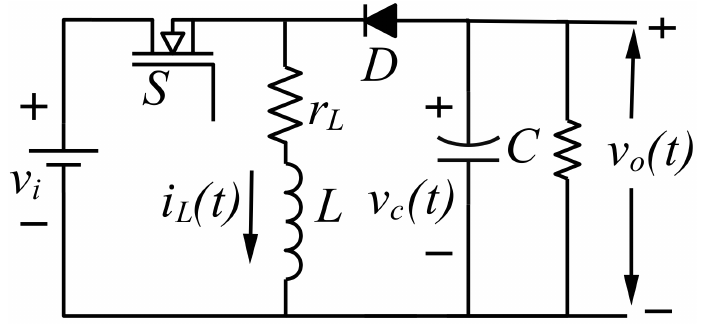
Figure 3. Buck-boost converter